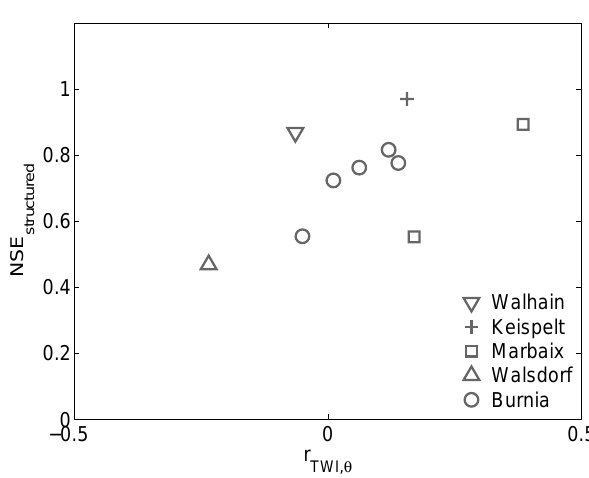
Fig. 8. Hydrographs from hydrologic simulation using the an- tecedent soil moisture maps from scenarios 1 to 4 and 7 for the field campaign in Marbaix, 15 April 2009. The average Connected hydrograph is depicted in a dashed-dotted line on top of the 1000 hydrographs from the simulated antecedent soil moisture maps.